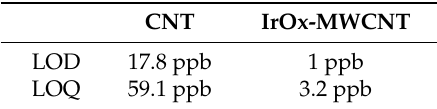
Table 1. The lower values obtained with IrO x loaded MWCNTs are due to the higher response and signal-to-noise ratio for this hybrid nanomaterial than for bare MWCNTs. Table 1. Estimated limits of detection and quantification for NO 2 . These theoretical levels should be confirmed with experimental measurements at this level of